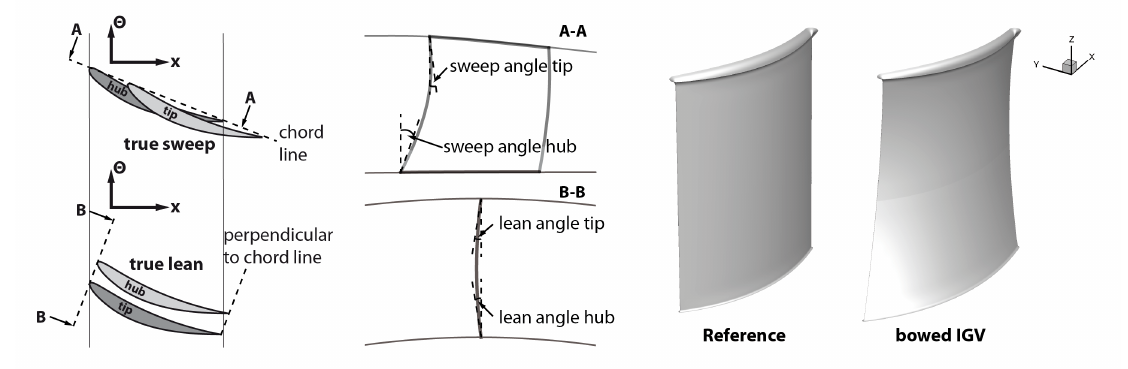
Figure 3. Sweep and lean of the inlet guide vane